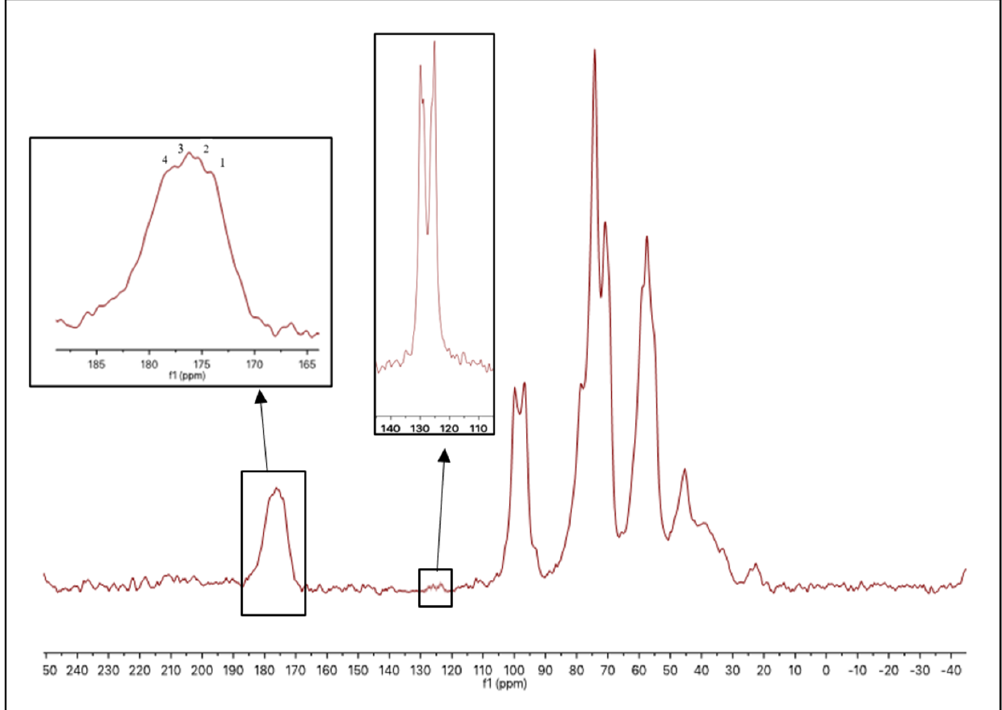
Figure 2. 13 C-NMR spectrum of SA.